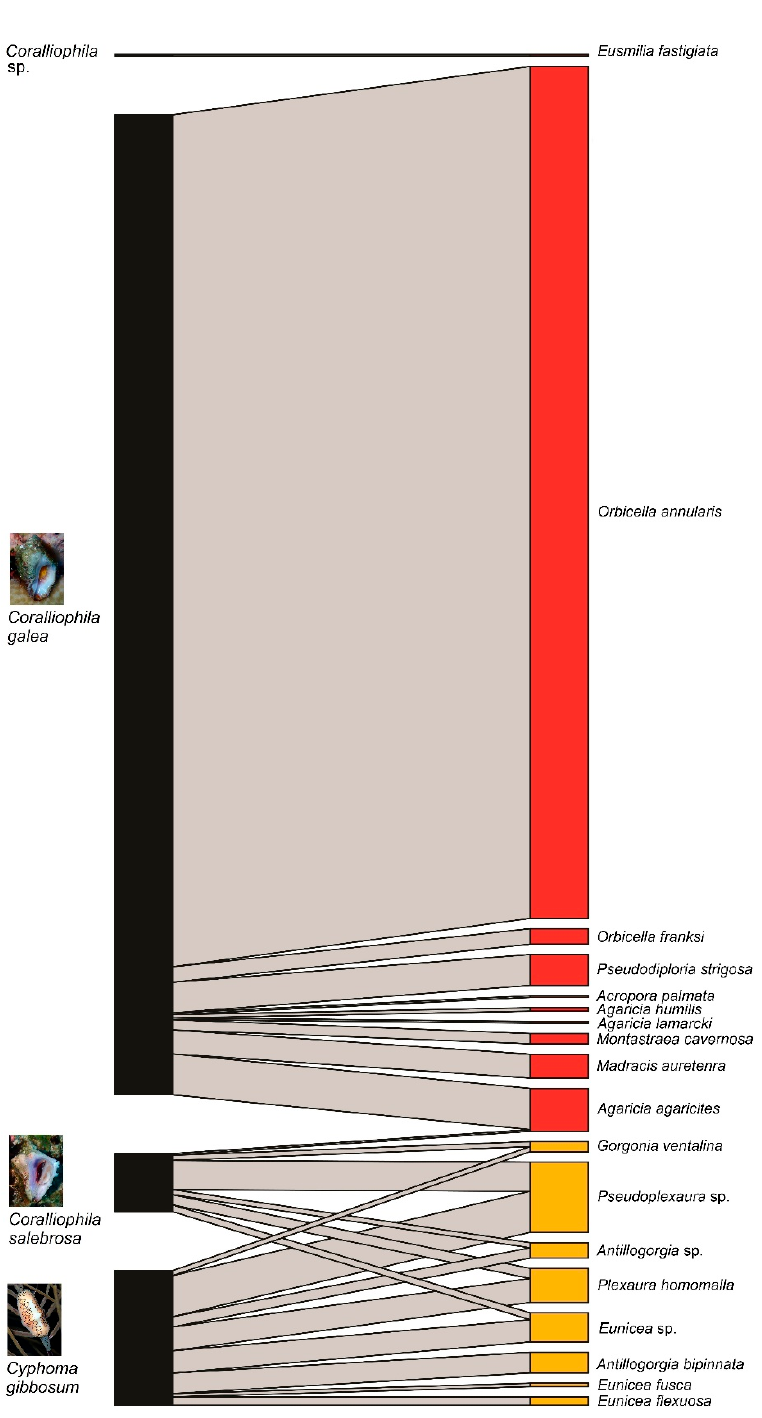
Figure 3. Bipartite network showing the associations between predator species (left side) and the host-coral species (right side: red = scleractinians; yellow = octocorals). The width of the grey lines represents the number of snails found per association. Coralliophila sp. is an unidentified snail.